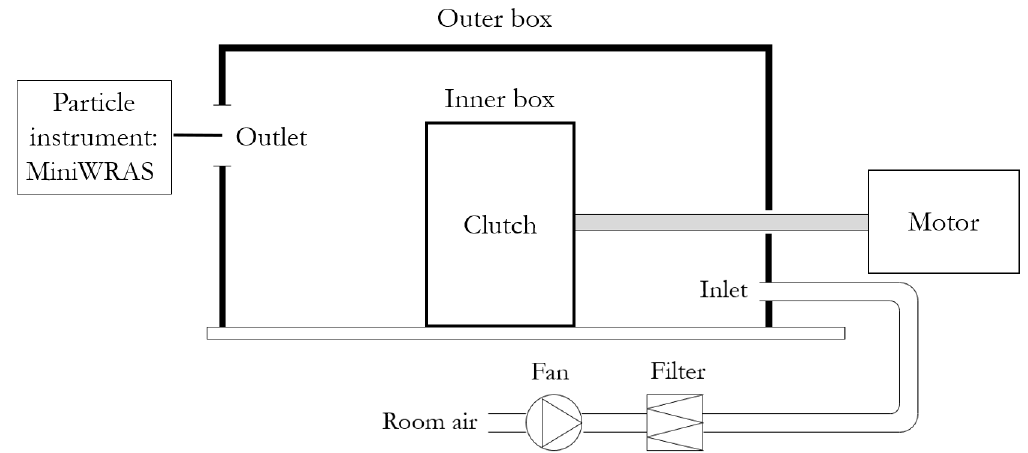
Figure 3. A schematic overview of the dry clutch tribometer.